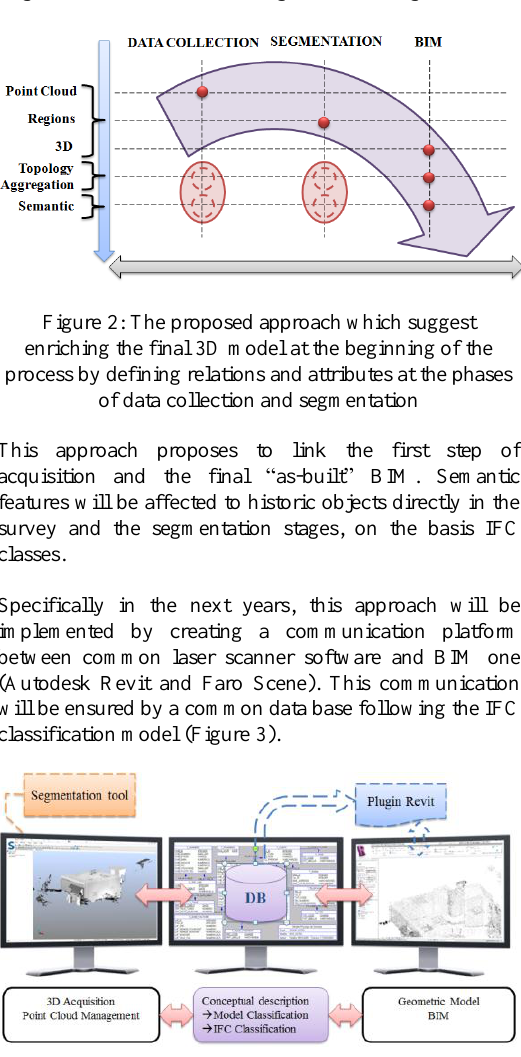
Figure 3: Illustration of the software environment of the approach based on a conceptual communication built according to an IFC classification